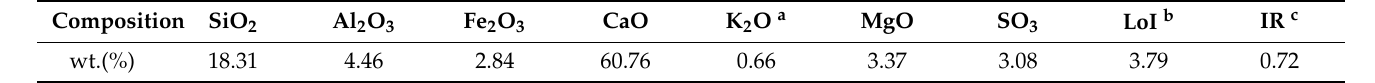
Table 2. Chemical composition of Portland cement.